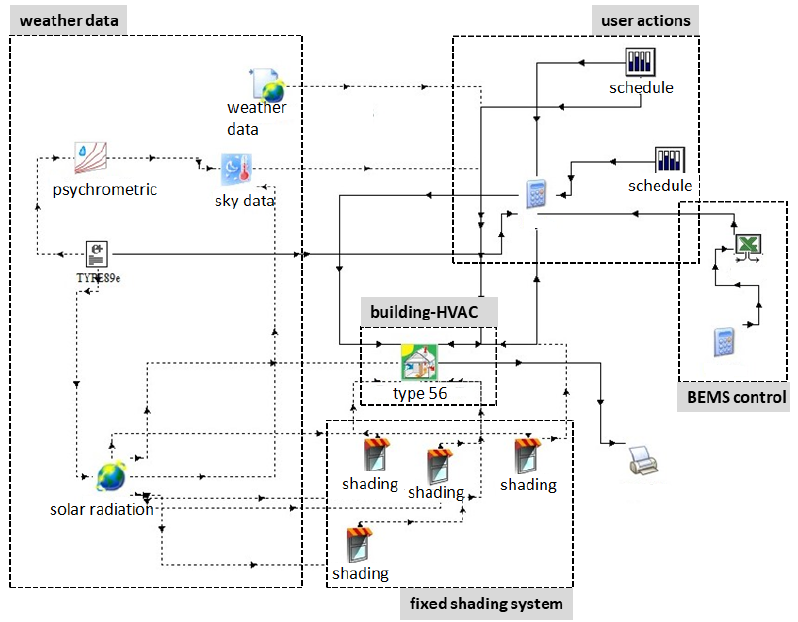
Figure 2. TRNSYS Simulation studio